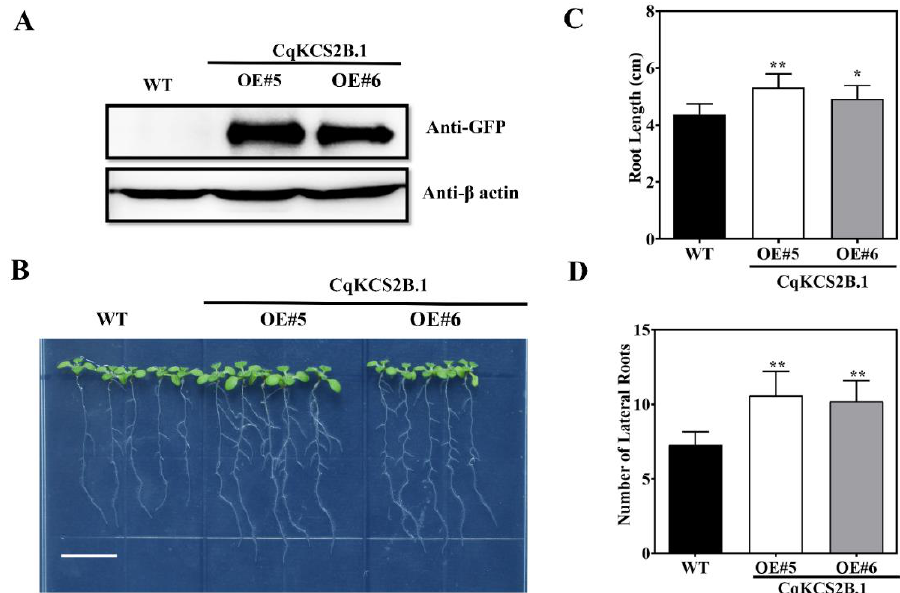
Figure 4. Ectopic expression of CqKCS2B.1 increases root elongation and lateral root synthesis. ( A ) Protein profiling of CqKCS2B.1 overexpressing lines OE#5 and OE#6, and wild-type (WT). Blot was probed with anti- β Actin and anti-GFP. ( B ) Root length and the number of lateral roots in WT and CqKCS2B.1 OE lines. The image shows OE lines (OE#5 and OE#6) seedlings on vertically oriented plate of 1 / 2 MS agar medium. ( C , D ) Root length and the number of lateral roots of 7-day-old seedlings of WT and CqKCS2B.1 OE lines (OE#5 and OE#6) at 3 d after transfer to a new 1 / 2 MS plate. Values are mean ± SD of 15 independent measurements. Significant differences were detected by ANOVA. * and ** indicate a significant difference between different transgenic line and WT at p < 0.05. and p < 0.01, respectively. Scale = 1 cm.